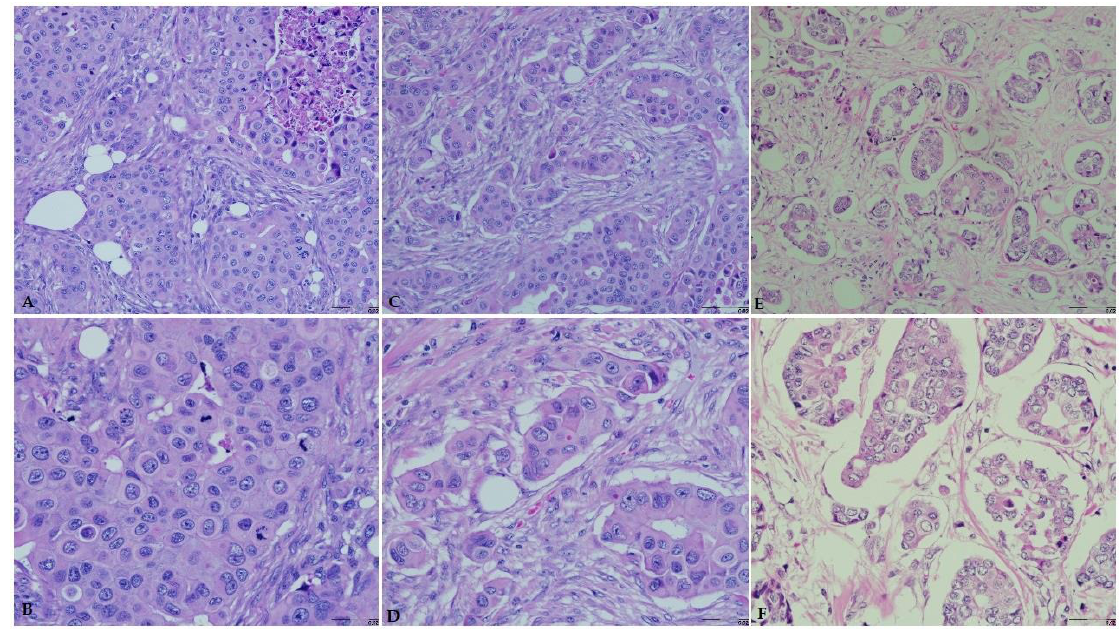
Figure 3. Breast carcinoma histological grade according to the Bloom–Richardson grading system. Hematoxylin and eosin staining (×20 and ×40). ( A ) High grade (grade III, ×20). ( B ) High grade (grade III, ×40). ( C ) High grade (grade II, ×20). ( D ) High grade (grade II, ×40). ( E ) Low grade (grade I, ×20). ( F ) Low grade (grade I, ×40).